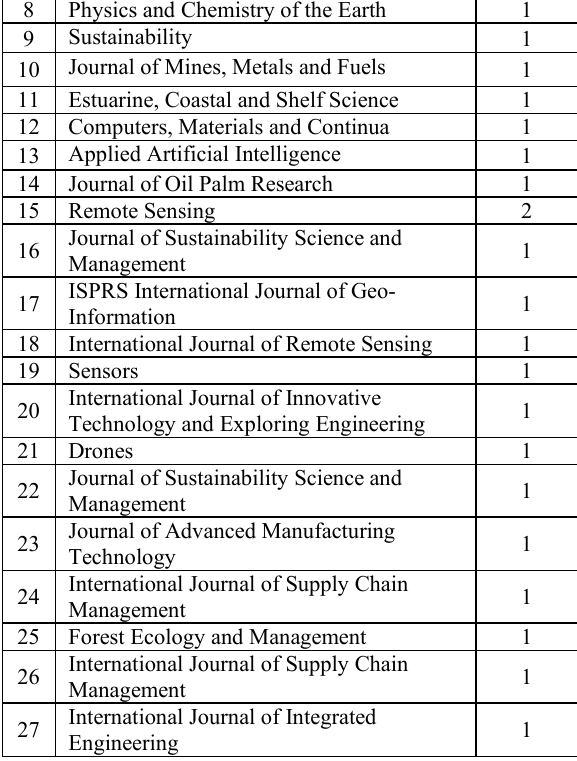
Table 1. The list of journals.